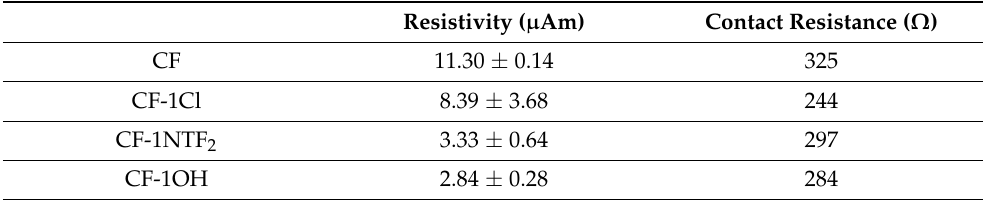
Table 1. Electrical resistivity and contact resistance of the CF